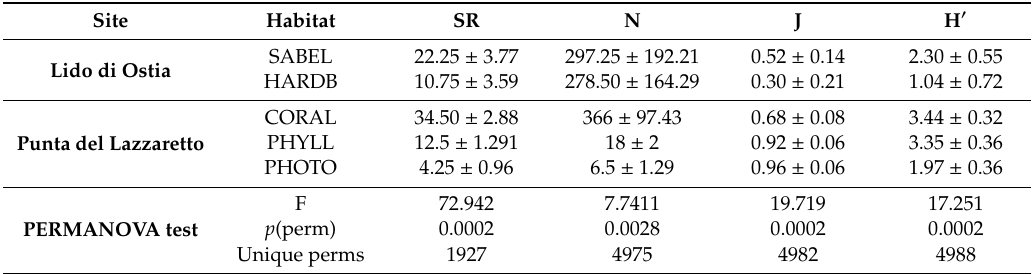
Table 2. Mean values (± SD) of sinecological indices (SR = number of species; N = number of individuals per 2 dm 3 ; J = evenness; H' = Shannon-Weaver diversity) for each habitat and site, and results of permutational analysis of variance [PERMANOVA test - F: F-value; p (perm): calculated probability value; Unique perms: the number of unique permutations].